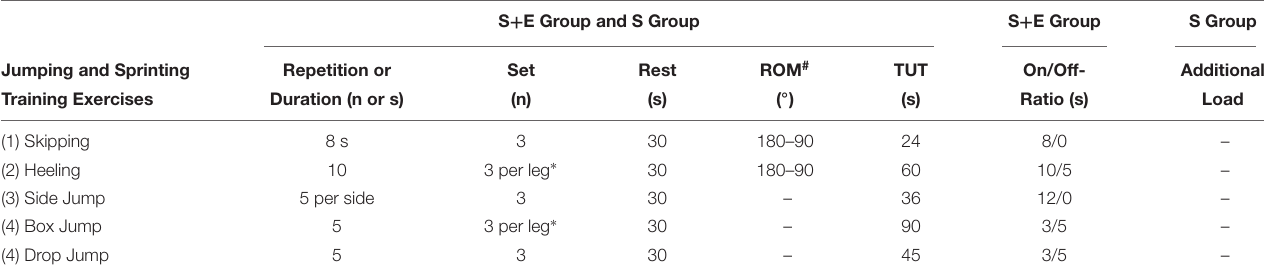
TABLE 3 | Jumping and sprinting training exercises with characteristics about repetitions, sets, rest between the sets, range of motion per repetition and time under tension (TUT) per exercise for both groups as well as on/off ratio of WB-EMS impulse (70% of the individual pain threshold) for the strength training group with superimposed WB-EMS (S + E) and additional load (individual 8–10 repetition maximum) for the strength training group